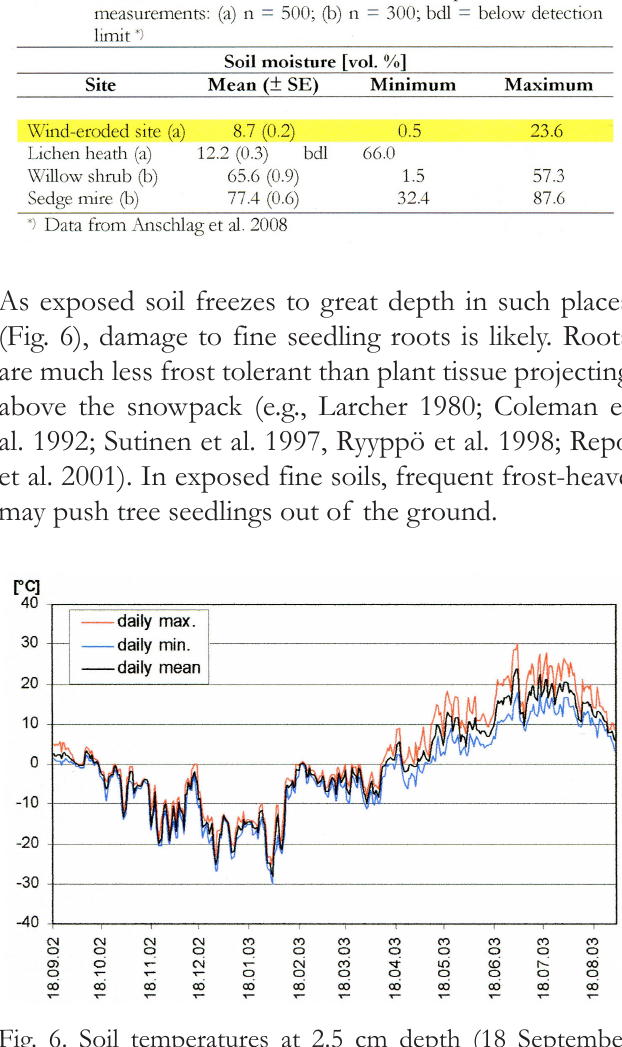
Fig. 6. Soil temperatures at 2.5 cm depth (18 September 2002 - 1 September 2003) on wind-eroded convex terrain at about 267 m (Staloskaidi, Finnish Lapland). In this place, winter snowpack does usually not last longer than a few days. The diurnal amplitude is very narrow in winter and increases considerably during summer. Data provided by